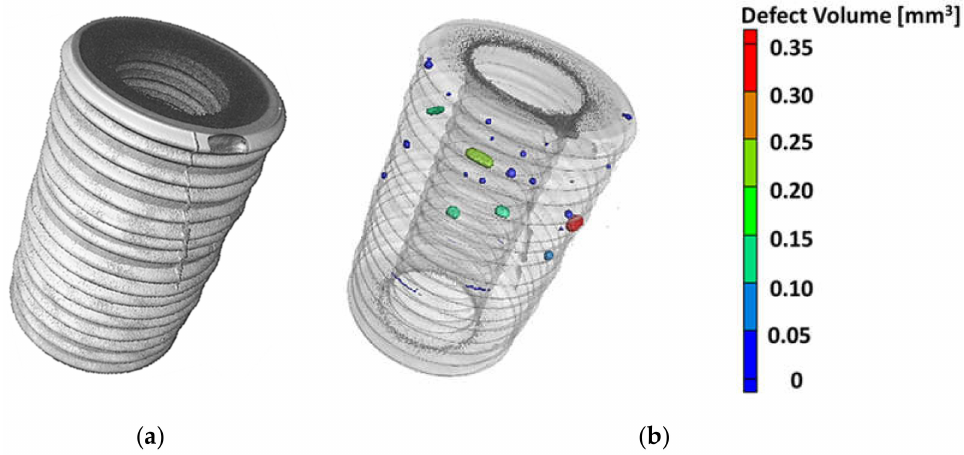
Figure 8. ( a ) 3D representation of the titanium insert, and ( b ) transparent representation with pore analysis, of a milled and sputtered